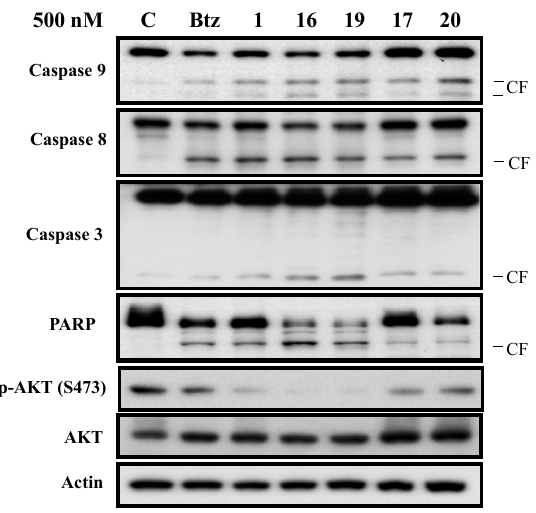
Figure 5. Western blot analysis of Akt (Akt1), p-Akt (Ser473), caspases and PARP levels. Sk-hep1 cells were exposed to bortezomib and derivatives at 500 nM in DMEM with 5% FBS for 24 h. Cell lysates were prepared for Akt (Akt1), p-Akt (Ser473), caspase-8, caspase-9, caspase-3, and PARP. CF, cleaved form (activated form).